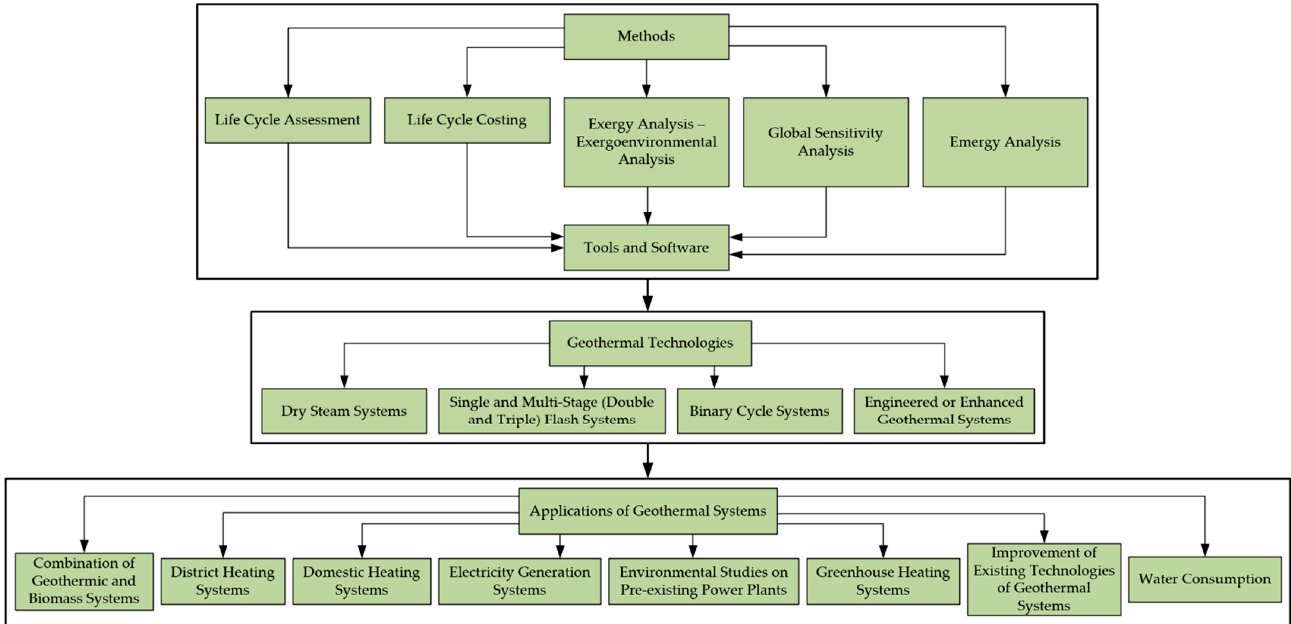
Figure 1. Flowchart indicating the contents of the present review.